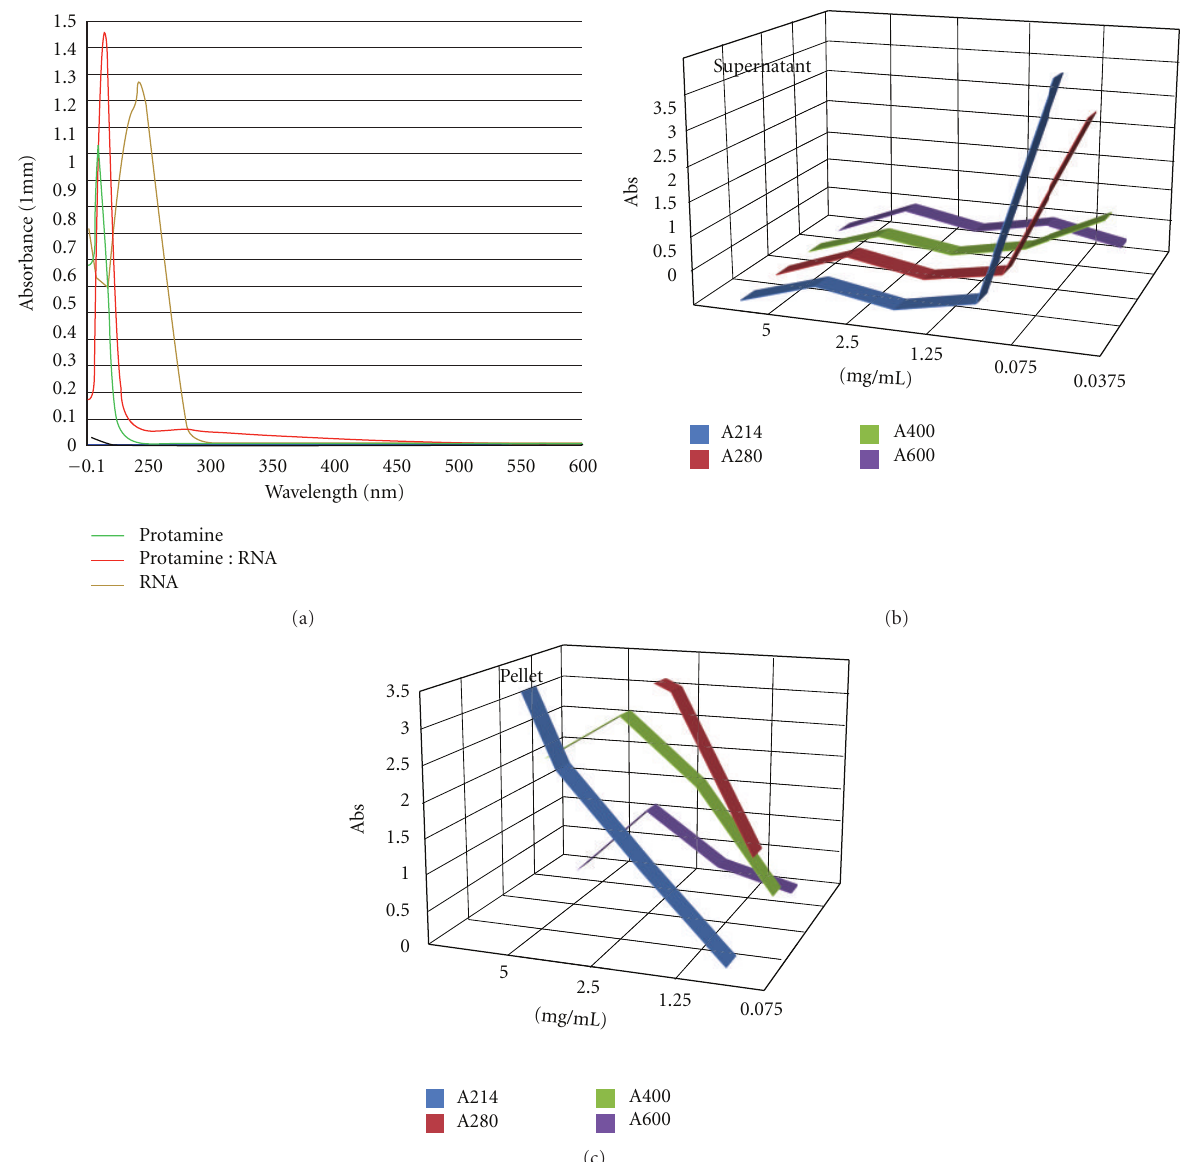
Figure 1: NanoDrop UV/Vis analysis of protamine:RNA and analysis of the sedimentation profiles at 214, 280, 400, and 600 nm.